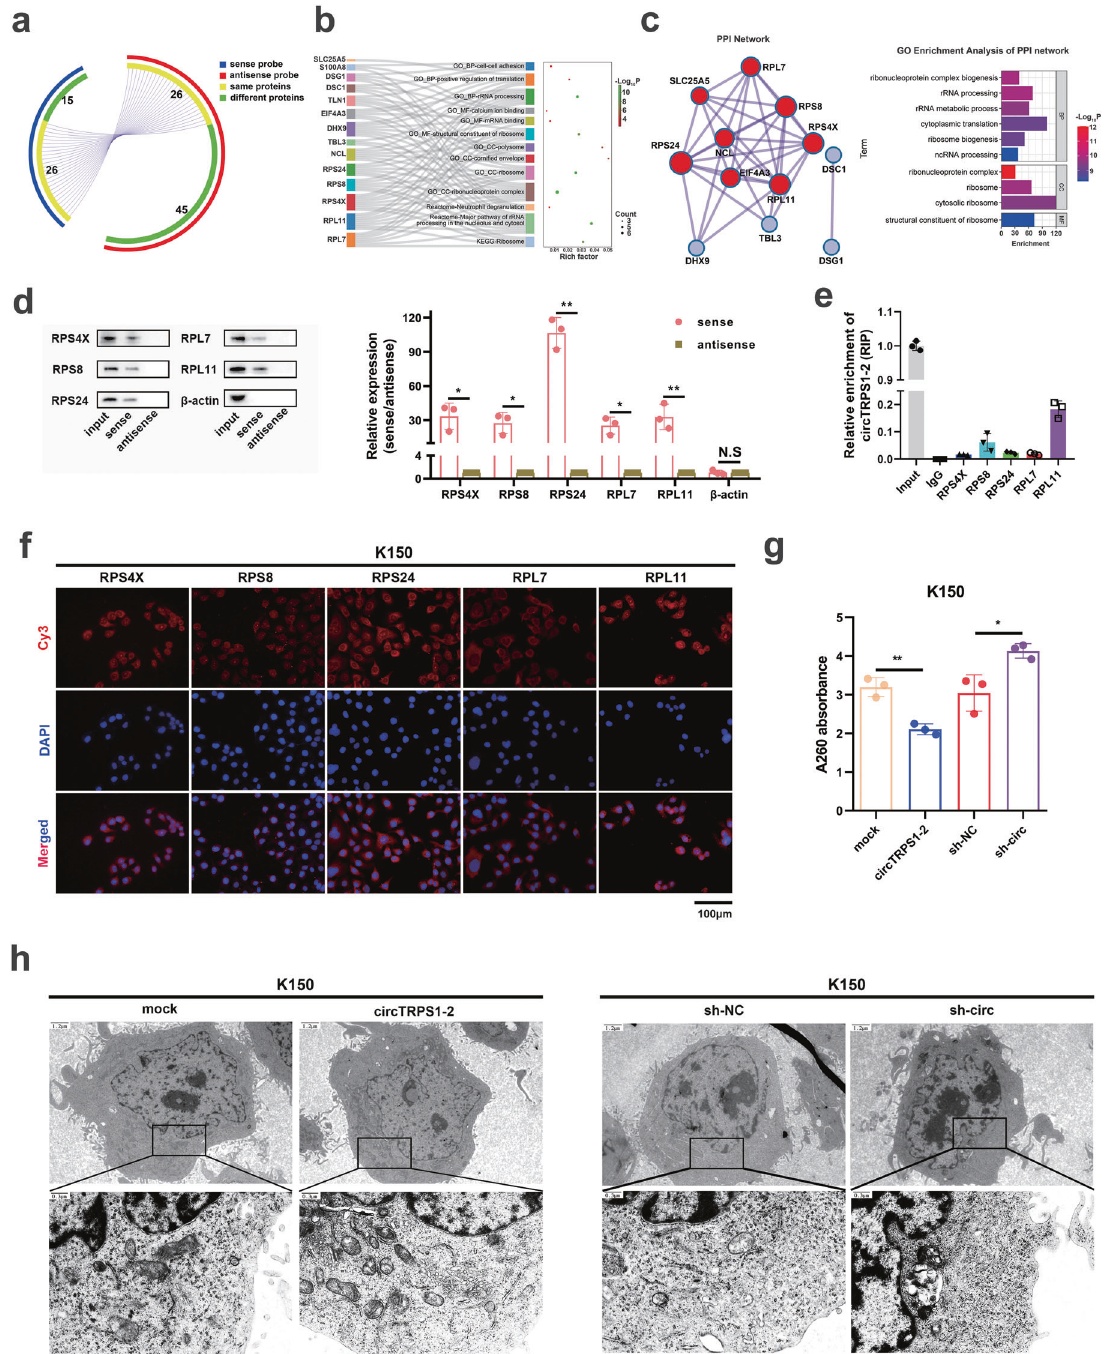
Fig. 6 Binding of circTRPS1-2 to ribosomal proteins and effects on ribosome biogenesis. a Circos overlap plot showing the number of proteins binding to the sense and antisense probes in the circTRPS1-2 pulldown assay in K150 cells. b GO enrichment analysis, Reactome pathway analysis and KEGG pathway enrichment analysis of proteins binding speci fi cally to circTRPS1-2. c Interactions among the proteins in panel b. d Western blotting against several ribosomal proteins in the RNA precipitate. e RIP was performed in K150 cell lysates using antibodies against RPS4X, RPS8, RPS24, RPL7, RPL11 or IgG. Enrichment of circTRPS1-2 was detected by qRT – PCR, relative to circTRPS1-2 expression of input group. Results are from three independent experiments. f Immuno fl uorescence of K150 cells to investigate the subcellular localization of RPS4X, RPS8, RPS24, RPL7 and RPL11. Magni fi cation, 400×. Scale bar, 100 µm. g Absorbance (260 nm) of total ribosome extracts from same number of K150 cells over- or underexpressing circTRPS1-2. Results are from three independent experiments. h Representative electron micrographs of ribosomes in K150 cells over- or underexpressing circTRPS1-2. The small and black particles in the cytoplasm are ribosomes. Magni fi cation, 20000×. Scale bar ( upper left of images ), 0.3 µm. Results are from three independent experiments. Data are mean ± SD. * P < 0.05, ** P < 0.01. circTRPS1-2, circTRPS1-2 overexpression lentivirus; GO, Gene Ontology; KEGG, Kyoto Encyclopedia of Genes and Genomes; mock and sh-NC, negative control lentivirus; RIP, RNA immunoprecipitation; RPS4X, ribosomal protein S4 X-linked; RPS8, ribosomal protein S8; RPS24, ribosomal protein S24; RPL7, ribosomal protein L7; RPL11, ribosomal protein L11; sh-circ, circTRPS1-2 shRNA interference lentivirus.